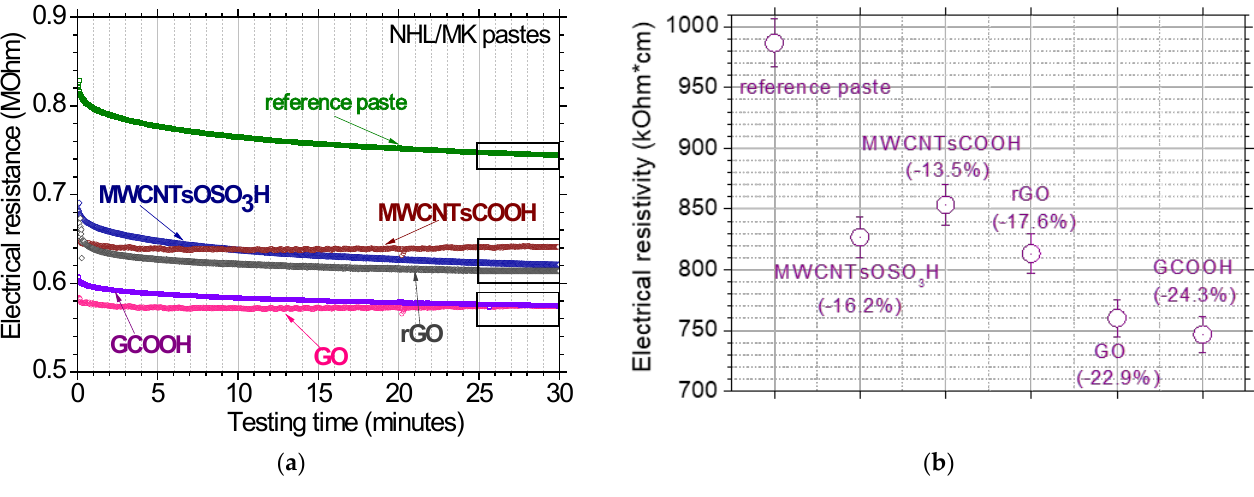
Figure 8. ( a ) Electrical resistance testing results for all investigated pastes and ( b ) electrical resistivity of the respective nano reinforced restoration pastes.